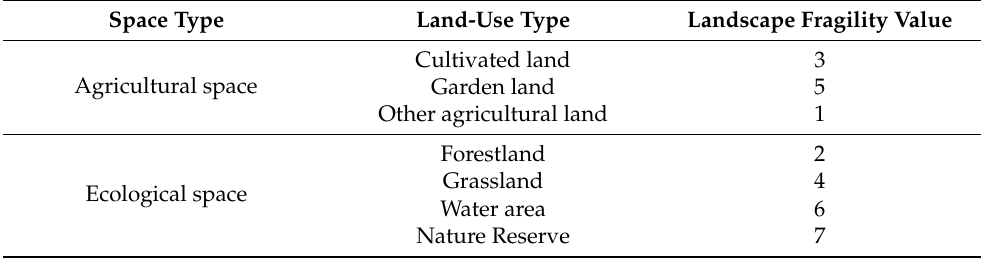
Table 1. Assessment of the landscape fragility of agricultural spaces and ecological spaces in Lin’an District. Space Type Land-Use Type Landscape Fragility Value Agricultural